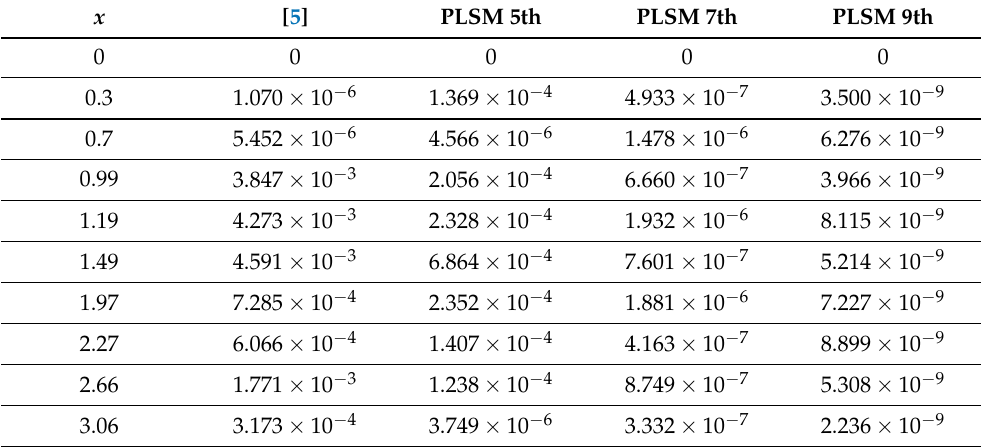
Table 1. Absolute errors of the approximations for problem